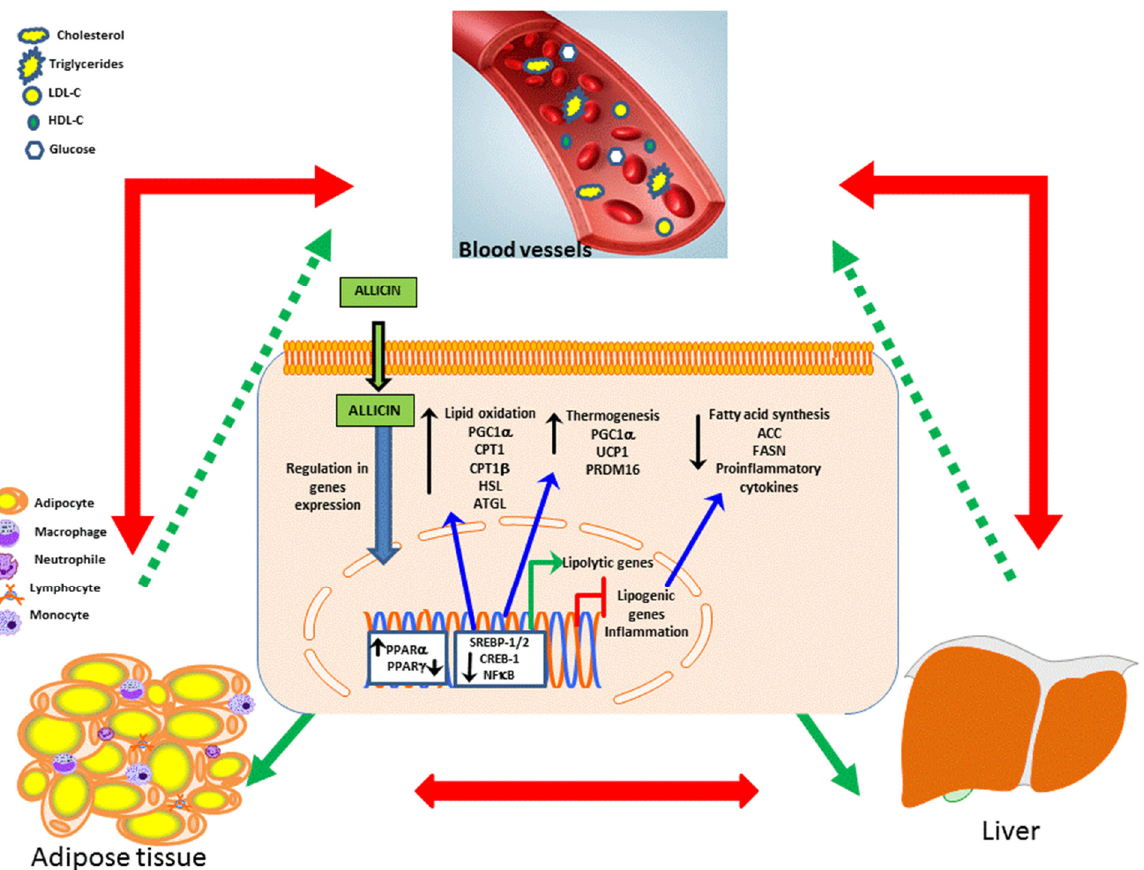
Figure 3. Effects of allicin on lipid metabolism: Allicin crosses the cell membrane and modulates transcription factors that regulate the expression of genes associated with lipid oxidation, thermogenesis, fatty acid synthesis and proinflammatory cytokines in the liver and adipose tissue improving the lipid profile. The red arrows indicate the close association between liver and adipose tissue dysfunction and its influence on the serum levels of the lipid profile and glycemia. The green arrows indicate the beneficial effects of allicin at the intracellular level in adipose and liver tissue and the final effect at the systemic level. Abbreviations: acetyl-CoA carboxylase (ACC), fatty acid synthase (FASN), AMP response element-binding protein (CREB); Sterol regulatory element-binding protein 1 (SREBP-1) and SREBP-2; Peroxisome proliferator-activated receptor alpha (PPARα); PPAR gamma (PPARγ); Pparγ coactivator 1α (Pgc1α); hormone-sensitive lipase (HSL); Adipose triglyceride lipase (ATGL); Uncoupling protein-1 (Ucp1); PR-domain containing 16 protein (Prdm16); low-density lipoprotein cholesterol (LDL-C); high-density lipoprotein cholesterol (HDL-C).